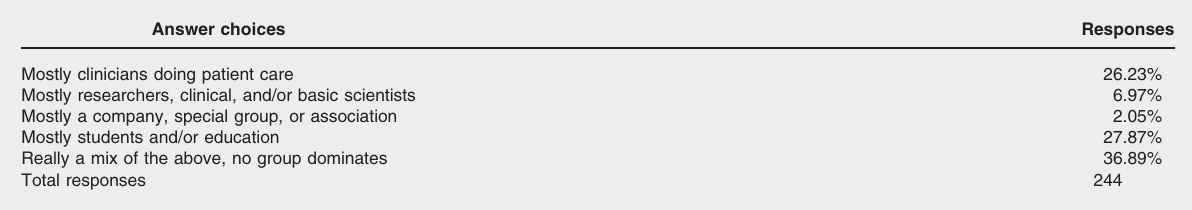
Who is the primary user of your